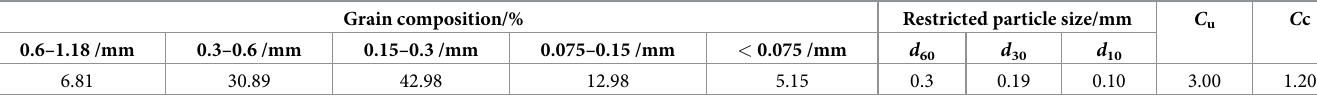
Table 1. Grain gradation of